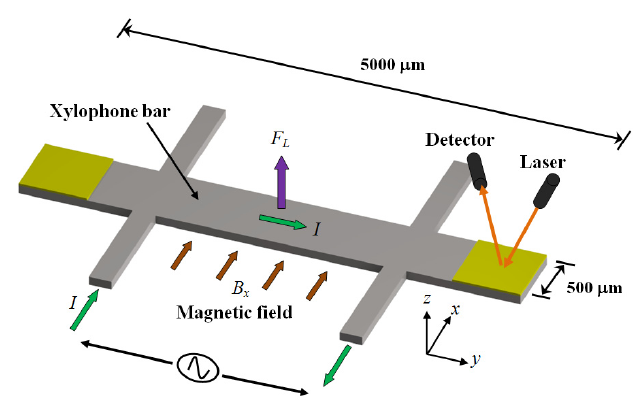
Figure 8. Schematic view of the operation principle of a magnetic field sensor based on a resonant xylophone microbeam designed by Zanetti et al . [44].